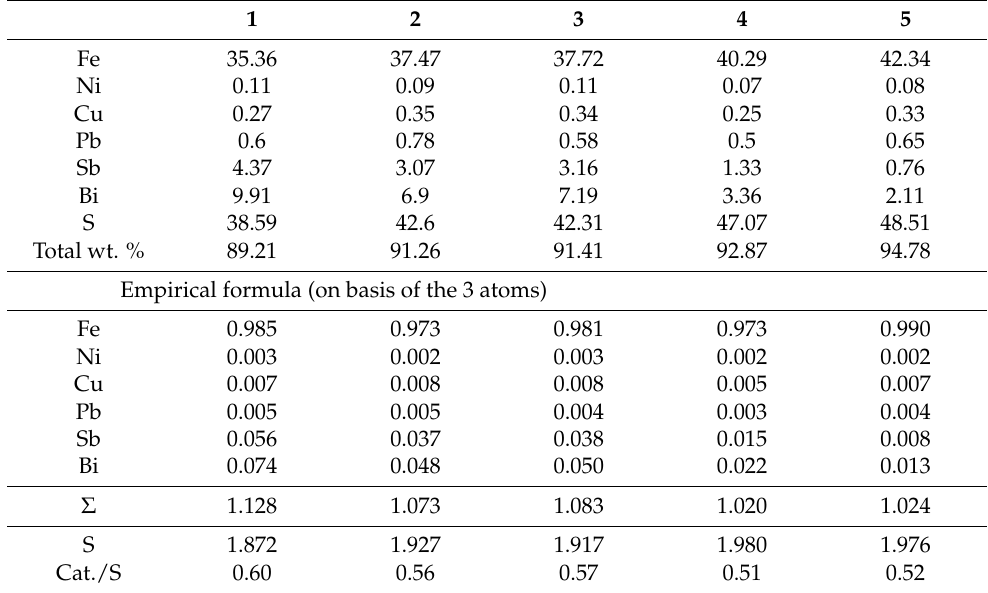
Table 4. Chemical composition of pyrite from ˇCuˇcma (Majersk á valley).